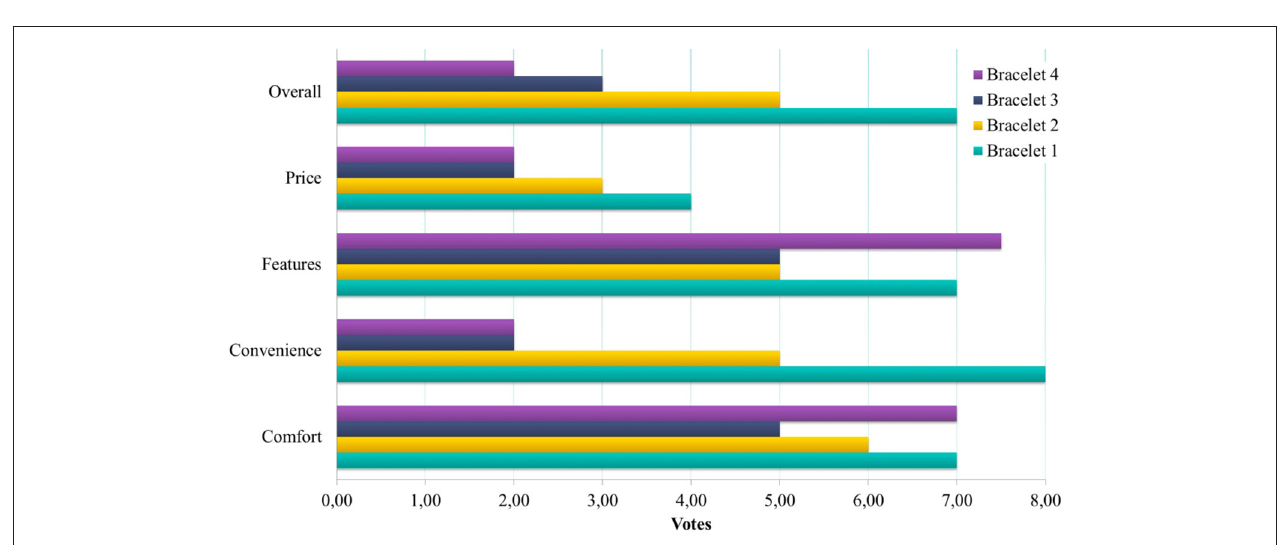
Frontiers in Aging Neuroscience | www.frontiersin.org